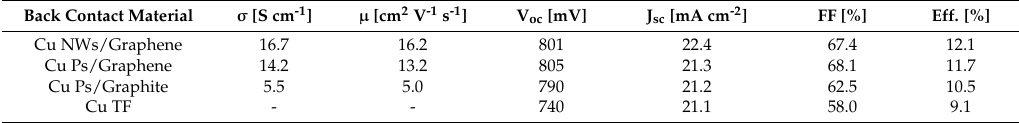
Figure 3. ( a ) Scanning electron microscopy (SEM) of a graphene incorporated CdTe film, insert figure was the top-view. ( b ) A schematic draw of 3D graphene-incorporated CdTe solar cell. ( c ) Band structure of the CdTe solar cell with graphene back contact. ( d ) J–V curve of CdTe solar cell with graphene back contact [39]. Table 1. Device performances of the CdTe cells with four different back contacts [40]. This table contains conductivity ( σ ), carrier mobility (µ), open circuit voltage (V oc ), short circuit current density (J sc ), fill factor (FF) and efficiency (Eff) for back contacts made with Cu thin films (Cu TFs) followed by a thick Ni layer, graphite or graphene paste containing Cu particles (Cu Ps, ≈ 75 µm in diameter) and copper nanowires (Cu NWs)/graphene.